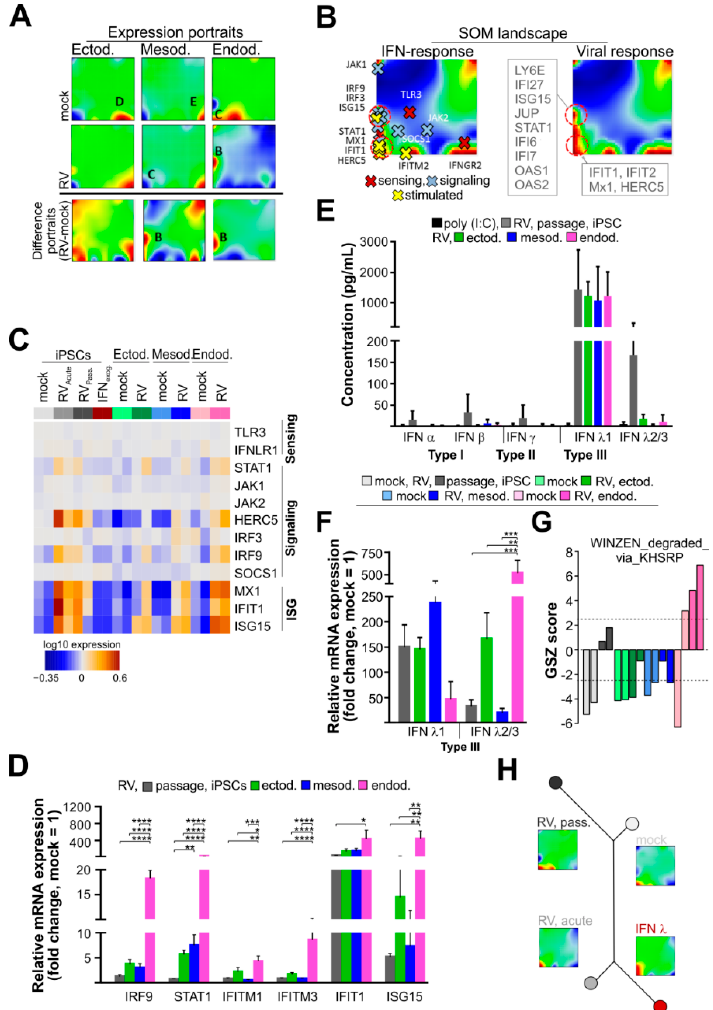
Figure 3. RV infection activates an IFN response in iPSCs and derived lineages. ( A ) Expression portraits of the embryonal germ layers before and after RV infection and the respective difference portraits reveal characteristic spot patterns, where spots C, D, and E are specific for endoderm, ectoderm, and mesoderm cells, respectively. Spot B appears after RV infection mainly in endodermal cells. ( B ) IFN response genes with signaling and stimulated functions in the IFN response pathways accumulate in spots B and C and were upregulated predominantly in iPS and endodermal cells after RV infection as also indicated by the IFN and viral response gene signature profiles. ( C ) Expression heatmap of selected marker genes involved in IFN-sensing and -signaling in mock- and RV-infected iPSCs and iPSC-derived lineages. Interferon-stimulated genes (ISGs) that were identified by the SOM analysis shown in ( A ) are included. ( D ) The mRNA expression level of the IFN-signaling components IRF9 and STAT1 and indicated ISGs was verified by RT-qPCR analysis. Data are given as means ± SD (n = 3 and n = 5 for RV-infected mesoderm, IRF9 and STAT1). ( E ) The IFN profile for RV-infected iPSCs and derived lineages was determined by the LEGENDplex IFN panel for undiluted supernatants collected after five (iPSCs and mesodermal cells) and seven days (endodermal and ectodermal) of cultivation. ( F ) The mRNA expression level of type III IFNs was verified by qPCR analysis and given as means ± SD (n = 3). ( G ) Mean expression of a gene set (gene set Z-score, GSZ) that is controlled by KSRP, which appears to keep inflammatory gene expression within defined limits [31]. ( H ) Similarity tree of the gene expression portraits of mock- and RV-infected iPSCs in comparison to iPSCs after cultivation in the presence of exogenous type III IFNs. ( D , F ) For normalization of qRT-PCR data in the 2 −∆∆ Ct method, the HPRT1 gene was used. See also Figure S3.